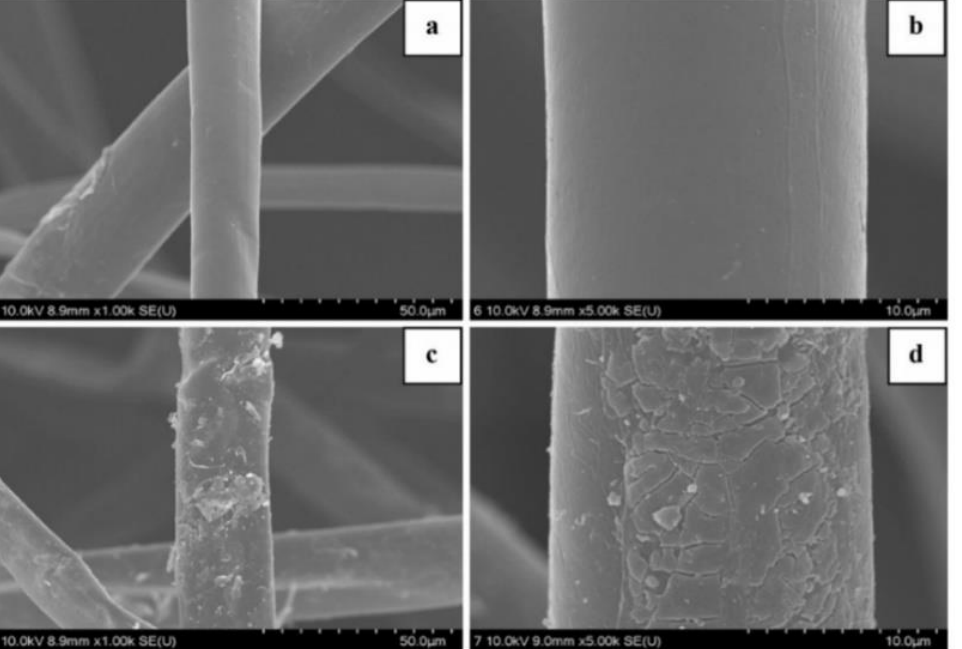
Figure 9. SEM micrographs at 10× and 50× magnification, respectively, of ( a , b ) raw KF and ( c , d ) KF under Fenton reaction [73]. Reprinted by permission from Springer Nature Customer Service Centre GmbH: Springer Nature, Environmental Earth Sciences, Removal of lead (II) from aqueous stream by hydrophilic modified kapok fiber using the Fenton reaction, Wang, D., Kim, D., Shin, C. H., Zhao, Y., Park, J. S., & Ryu, M., Copyright (2018).